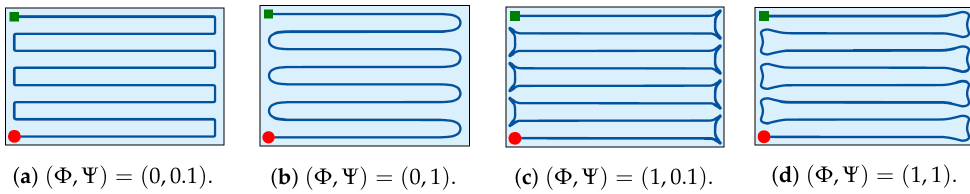
Figure 18. Smoothing parameter limit cases. The path starting point is indicated as a green square while the path end point as a red